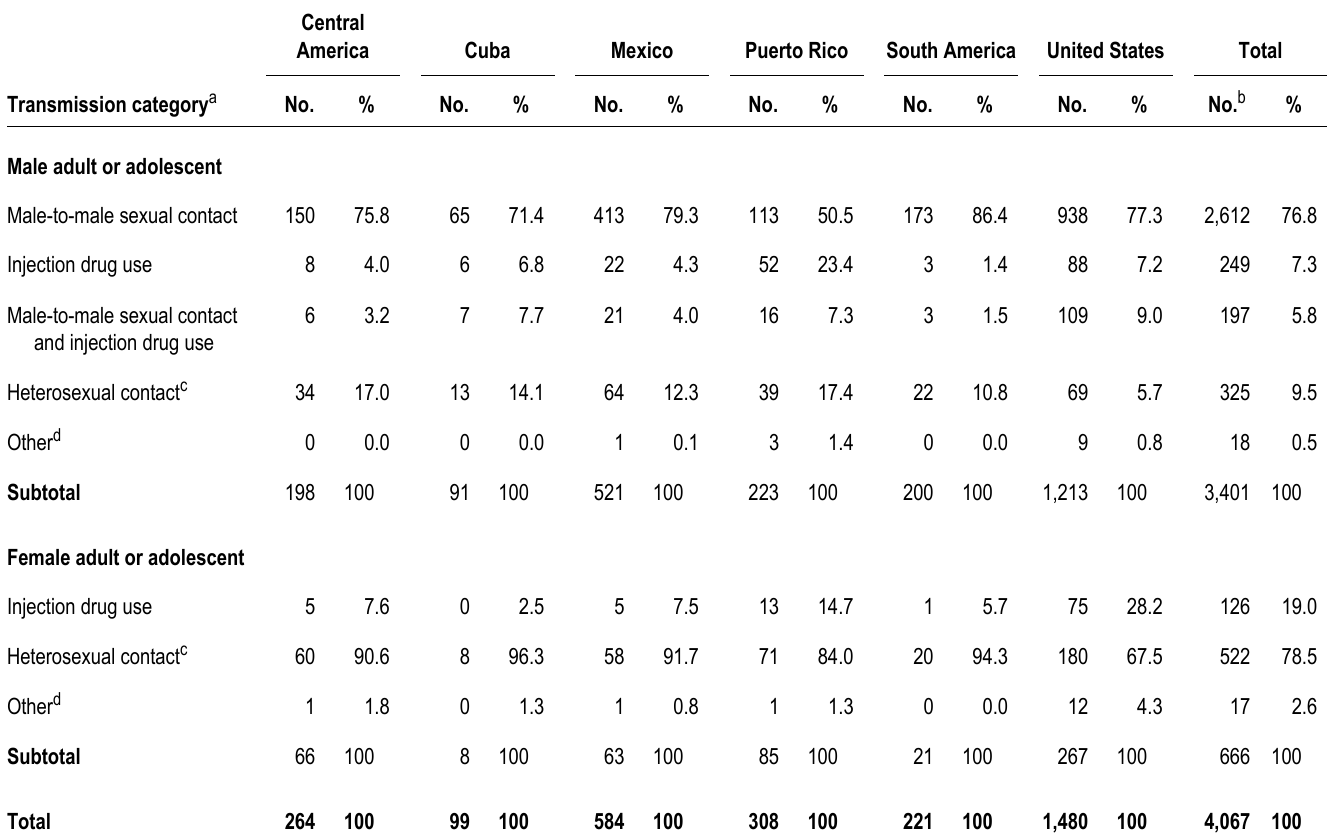
Table 17. Stage 3 (AIDS) among adult and adolescent Hispanics/Latinos, by transmission category and place of birth, 2018— United States and 6 dependent areas Central America Cuba